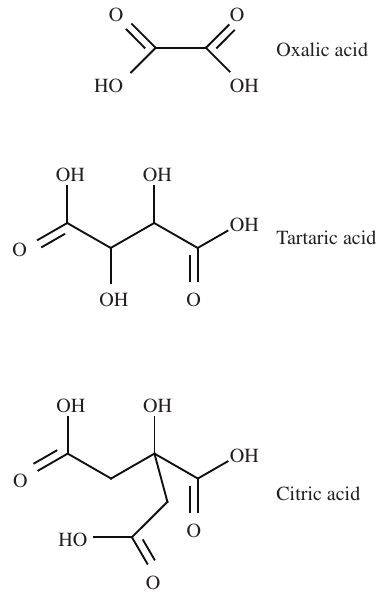
Figure 2. Structures of organic acids used as electrolytes to deposit the PPy films.